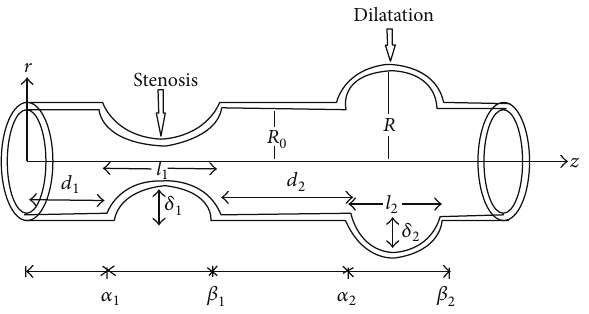
Figure 1: Geometry of an axially nonsymmetrical artery with ste- nosis and dilatation.